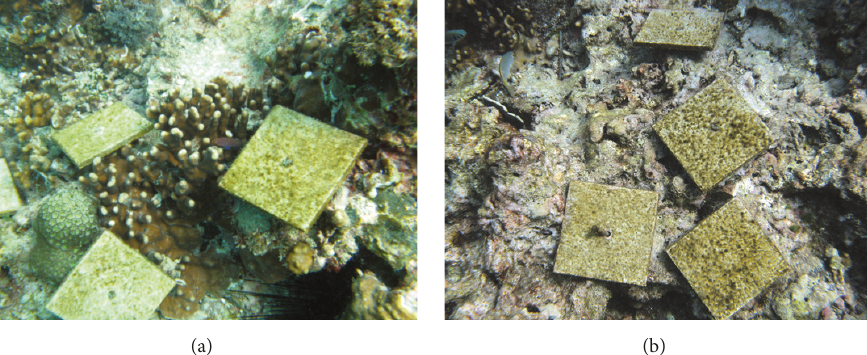
Figure 1: Four sets of four tiles each were placed either directly inside H. coerulea aggregations (a) or on rocky substrate away from the coral (b). Replicate sets of tiles were placed at least 2-3m away from each other within a reef area of about 10 × 10m at 5-6m depth in the Malilnep channel, Bolinao Reef Complex, northwestern Philippines.